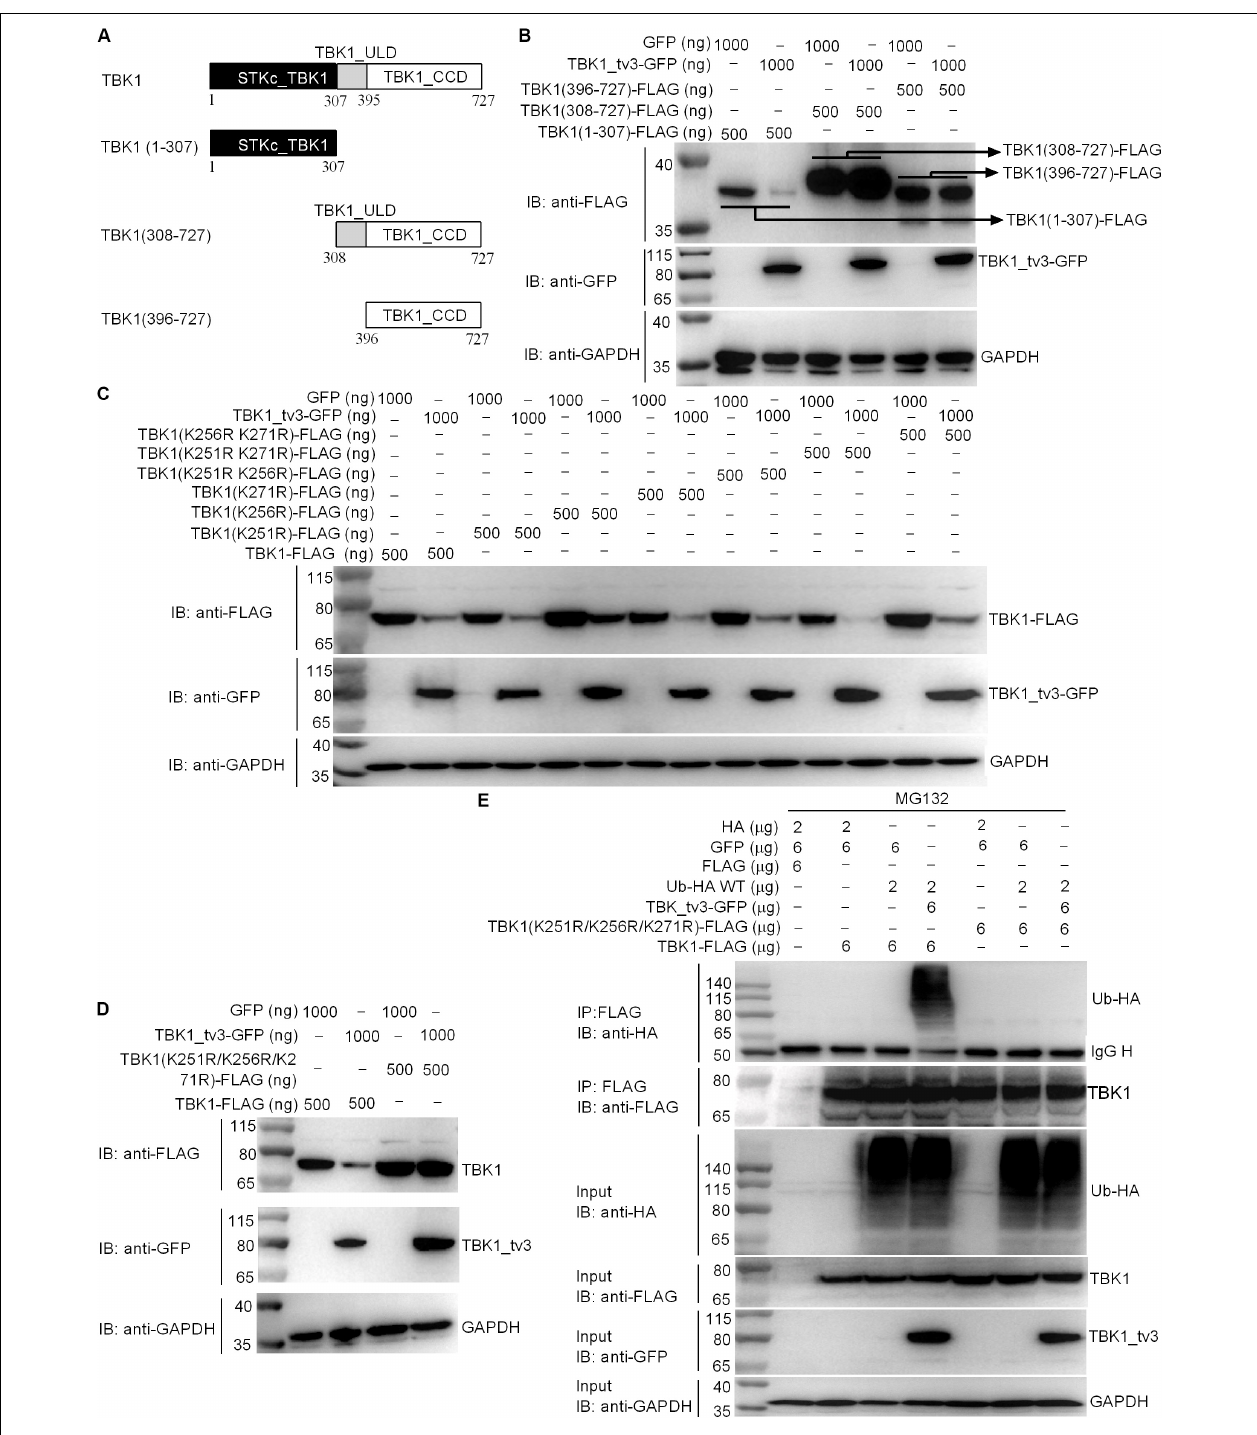
FIGURE 7 | The K251, K256, and K271 sites are vital for K48-linked ubiquitination of TBK1. (A) A schematic of TBK1 and truncated mutants. (B) The effect of TBK1_tv3 on the protein expression of TBK1 truncated mutants. (C,D) The effects of TBK1_tv3 on the protein expression of TBK1 with site mutants. For B–D , EPC cells were seeded in six-well plates and transfected with various indicated plasmids with indicated DNA concentration. After 48 h post-transfection, cell lysates were analyzed by immunoblotting using the indicated Abs. (E) The effect of TBK1_tv3 on the K48-linked ubiquitination of wild type and TBK1 with site mutant (K251R, K256R, and K271R). HEK 293T cells were seeded in 10-cm 2 dishes and transfected with 2 µ g HA, 6 µ g p3xFLAG, 6 µ g pTurboGFP, 2 µ g Ub-HA WT, 6 µ g TBK1_tv3-GFP, 6 µ g TBK1 (K251R, K256R, and K271R)-FLAG, and 6 µ g TBK1-FLAG with the indicated combination. At 18 h post-transfection, the cells were treated with MG132 for 6 h. Cell lysates were IP with anti-FLAG-conjugated agarose beads. The cell lysates and bound proteins were analyzed by immunoblotting with the indicated Abs. All experiments were repeated for at least three times with similar results.